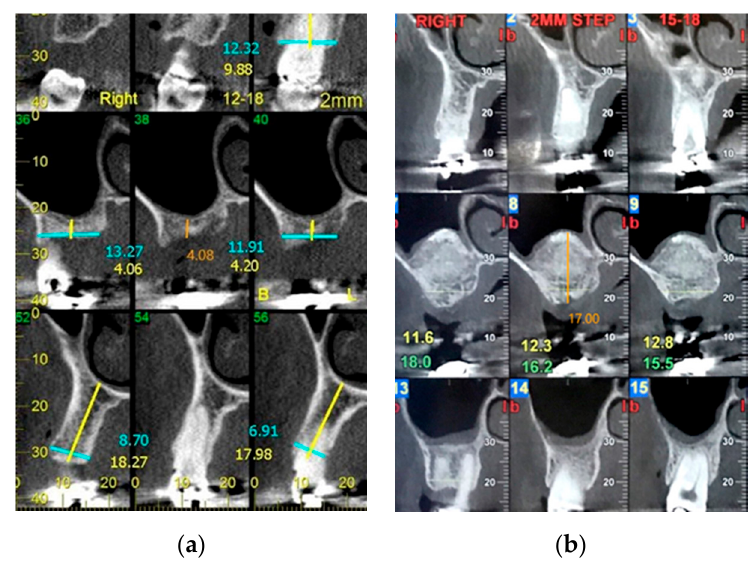
Figure 2. Representative CT images shown by the AB Denpax Viewer, presenting the vertical ridge